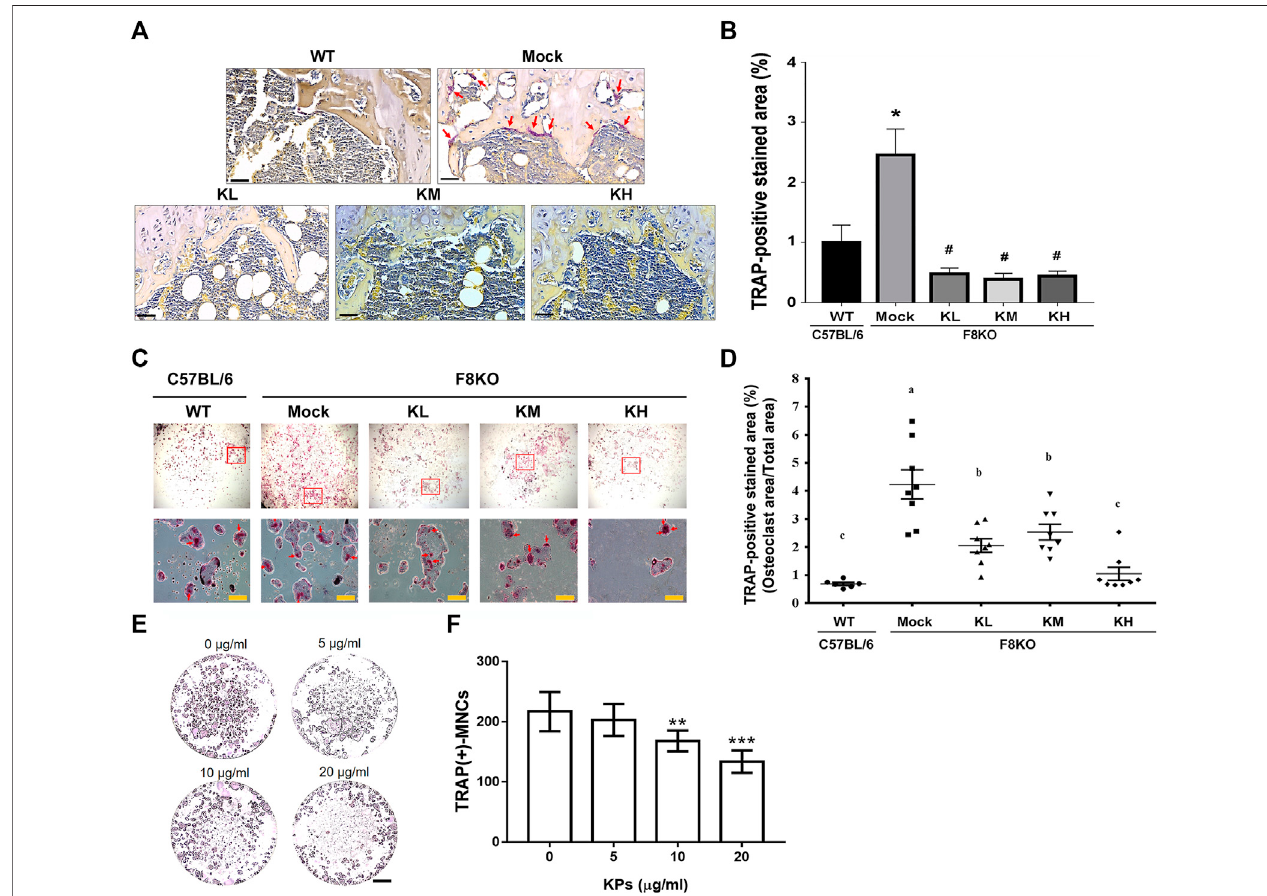
FIGURE7| EffectsofKPtreatment onosteoclastdifferentiation. (A) TRAPstainingoftheparaf fi n-embeddedfemoraltissuesectionsfromeach group.Thepurple- colored TRAP-positive osteoclasts were indicated with red arrows in mock group. Scale bar = 30 µm. (B) TRAP-positive stained areas in each group were quantitated and compared using ImageJ software. * p < 0.05 vs WT group; # p < 0.05 vs mock group. (C) TRAP-staining of mature osteoclasts differentiated from the fl ushed bone marrow cells with the stimulation of M-CSF and RANKL for 14 days. The multinucleated osteoclasts in squares were magni fi ed and indicated by red arrows. (D) TRAP-positive stained areas in each group were quantitated and compared using ImageJ software. * p < 0.05, ** p < 0.01 vs WT group; # p < 0.05, ## p < 0.01 vs. mock group. (E) KPtreatmentinhibitsRANKL-inducedosteoclastogenesis inthecultureofbonemarrowmacrophages(BMMs).Tostimulateosteoclastdifferentiation,BMMs were stimulated with M-CSF (25 ng/ml) and RANKL (50 ng/ml) in the presence of various concentrations of KPs. TRAP staining was performed at the 5 th day of incubation. (F) TheTRAP-positivemultinucleatedcellswiththenumberofnucleus ≥ 3wereconsideredasmatureosteoclasts.** p < 0.01,*** p < 0.001vs.0 μ g/mlofKPs; Scale bar = 1